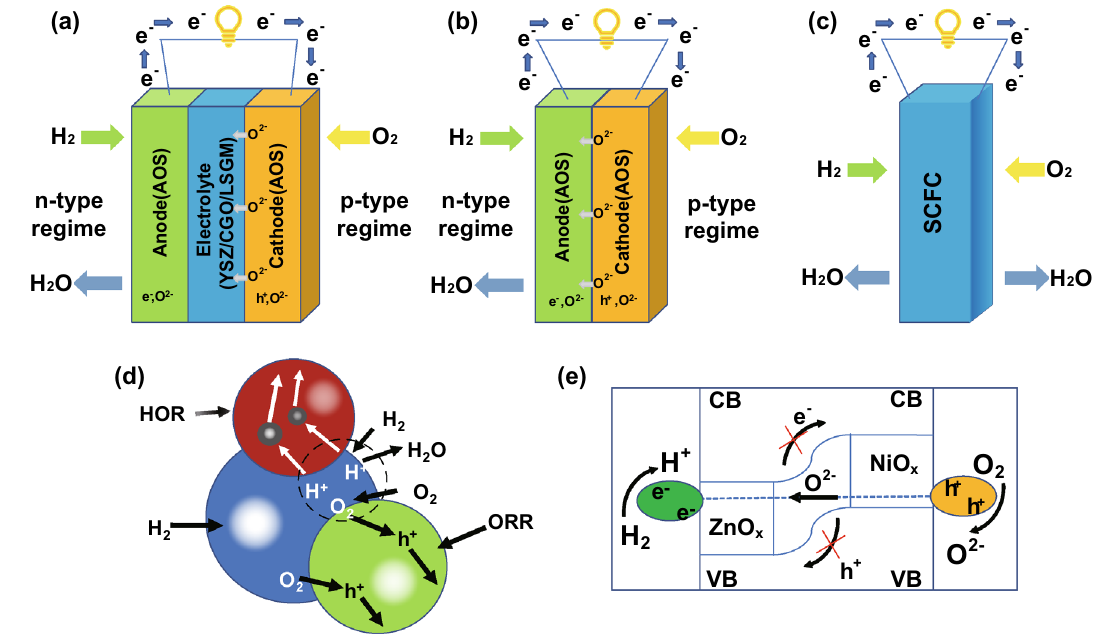
Fig. 1 Schematic representation of different kinds of fuel cells: a conventional solid oxide fuel cells (SOFCs). b Double‑layer fuel cell (DLFC), c SCFC, d SCFC–nanoredox fuel cell, e band alignment for